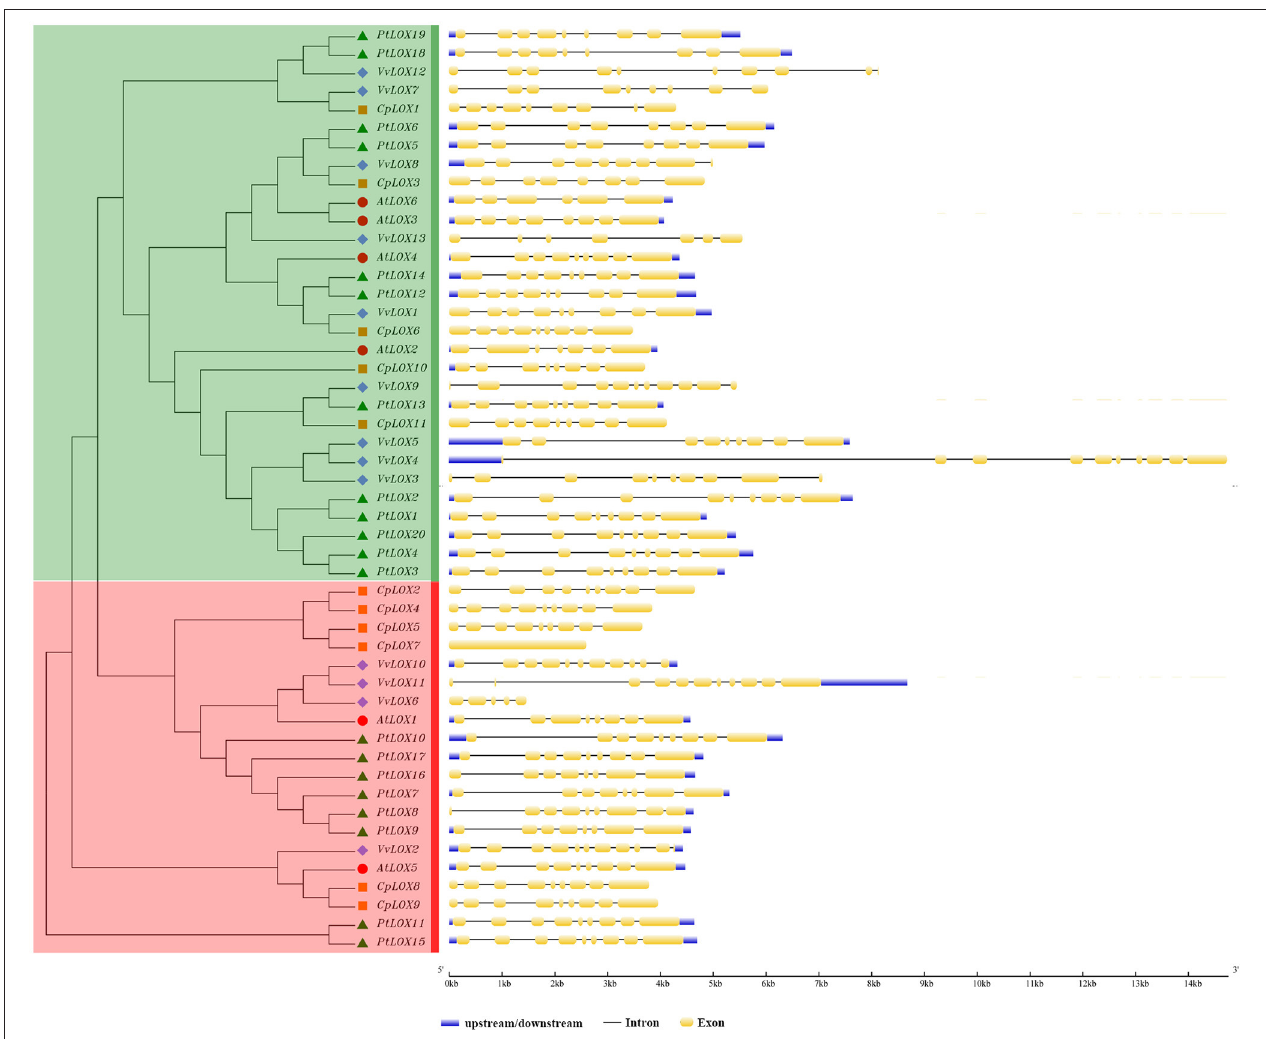
FIGURE 2 | Phylogenetic relationship of LOX proteins and the exon-intron structure of LOX genes from four rosid plants. Left: an unrooted phylogenetic tree constructed using MEGA 6.0 by the ME method. Different sub-families of LOX genes are highlighted with different colored backgrounds. Right: exon-intron structure. The exons and introns are indicated by yellow rectangles and thin lines, respectively. The untranslated regions (UTRs) are indicated by thick purple lines.